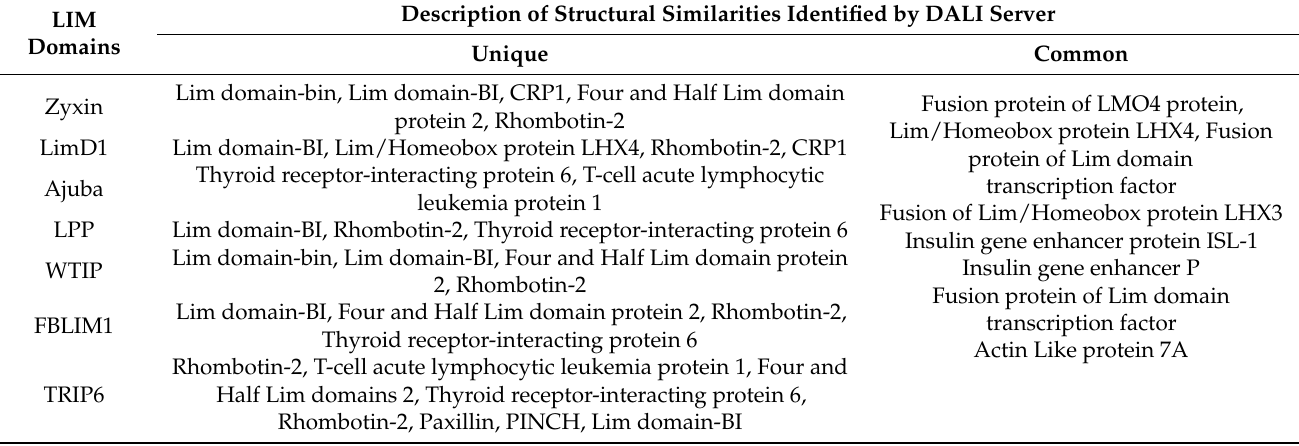
Table 5. DALI structural alignment of the LIM domain of Zyxin family